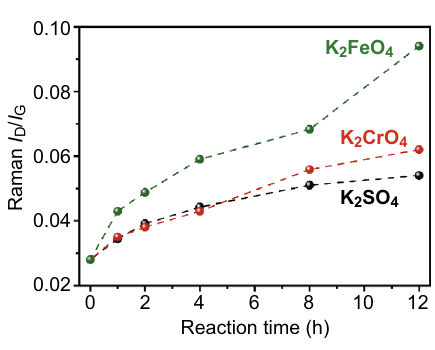
Fig. 5 I D / I G ratio results of GCNTs by solid‑state milling (250 rpm) with three isomorphous salts. A comparison of Raman spectra is shown in Fig.